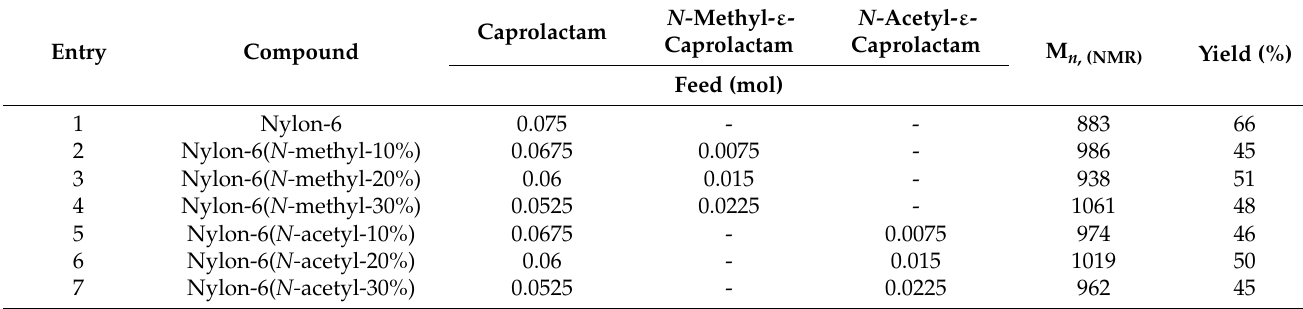
Table 1. Feed ratio and molecular weight data of the nylon